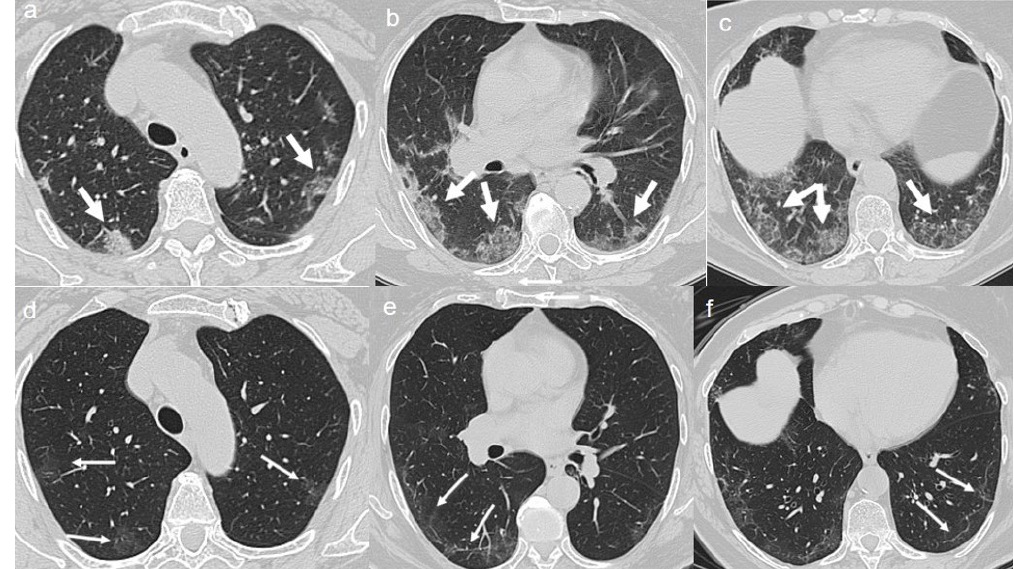
(arrows). ( d – f ) CT after 4 months from the onset of symptoms shows bilateral persistence of mixed pattern of GGOs (thin arrows in d ) and fibrous streaks (thin arrows in e , f ).